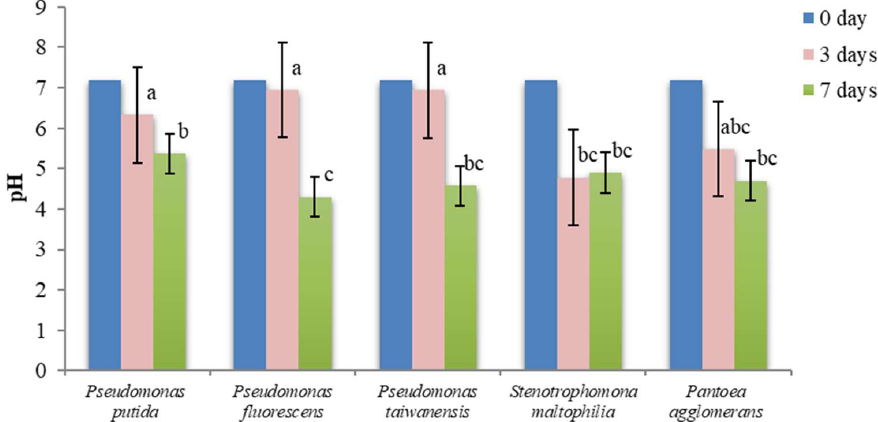
Figure 5. Variation of pH in PVK culture medium. Vertical bars represent confidence intervals at a confidence level of 95% (n = 3). Same letters indicate that differences among the means is not statistically significant (Tukey’s HSD post hoc test).